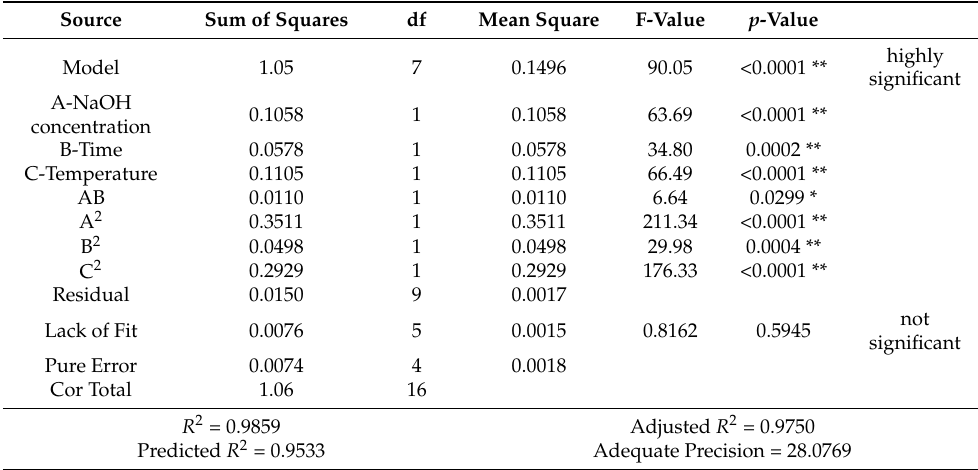
Table 4. ANOVA for coir fiber elastic